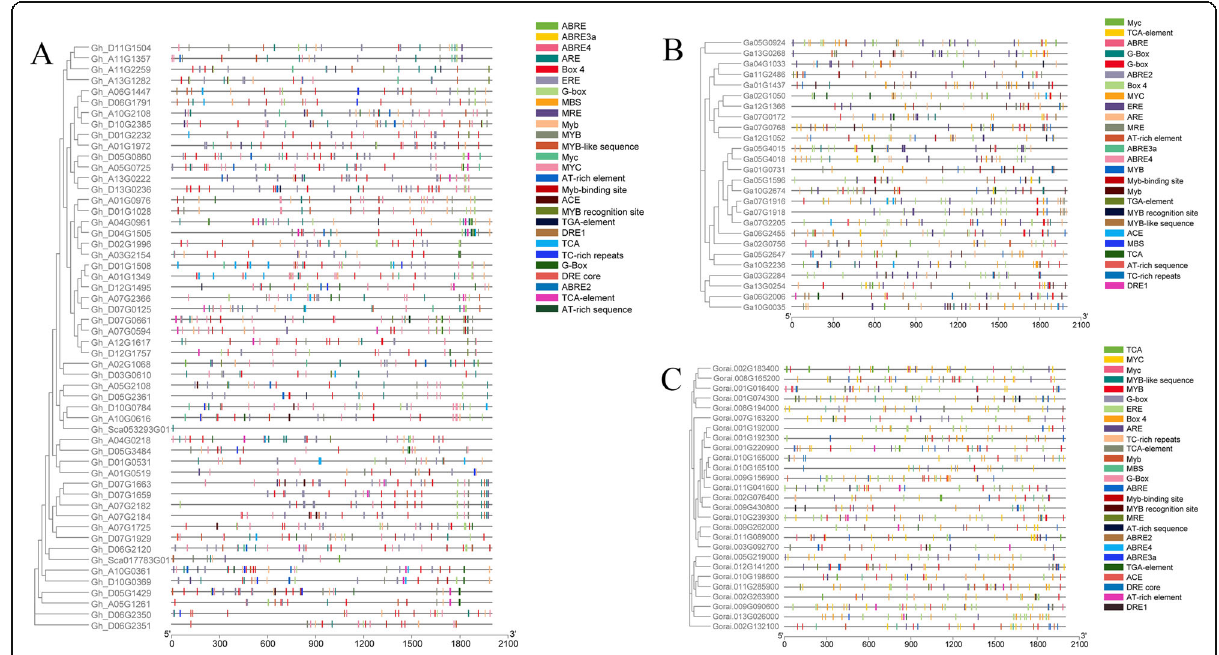
Fig. 6 Cis-regulatory elements analysis obtained for the various proteins encoded by the LHC genes in three Gossypium Species a G. hirsutum b G. arboreum c G.